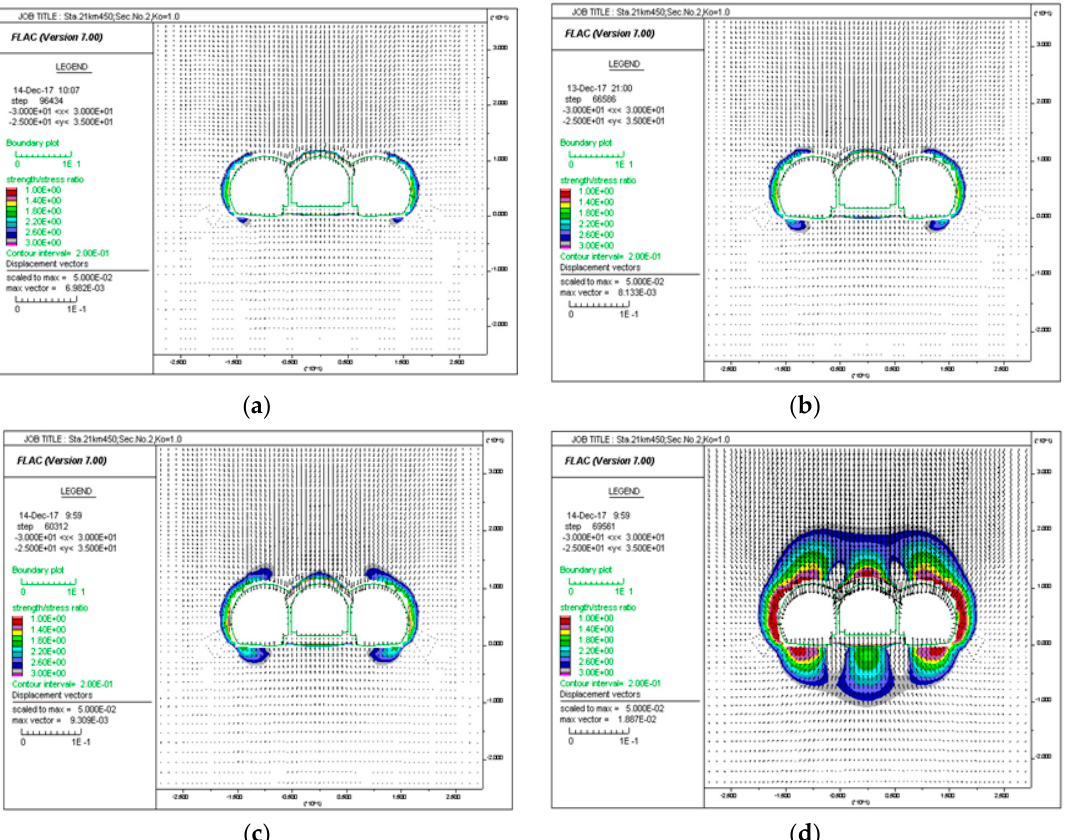
Figure 8. Estimation of rock load based on the factor of safety = 3.0 in rock mass class III, ( a ) overburden = 40 m (1.3 D); ( b ) overburden = 50 m (1.7 D); ( c ) overburden = 60 m (2.0 D); ( d ) overburden = 70 m (2.3 D).